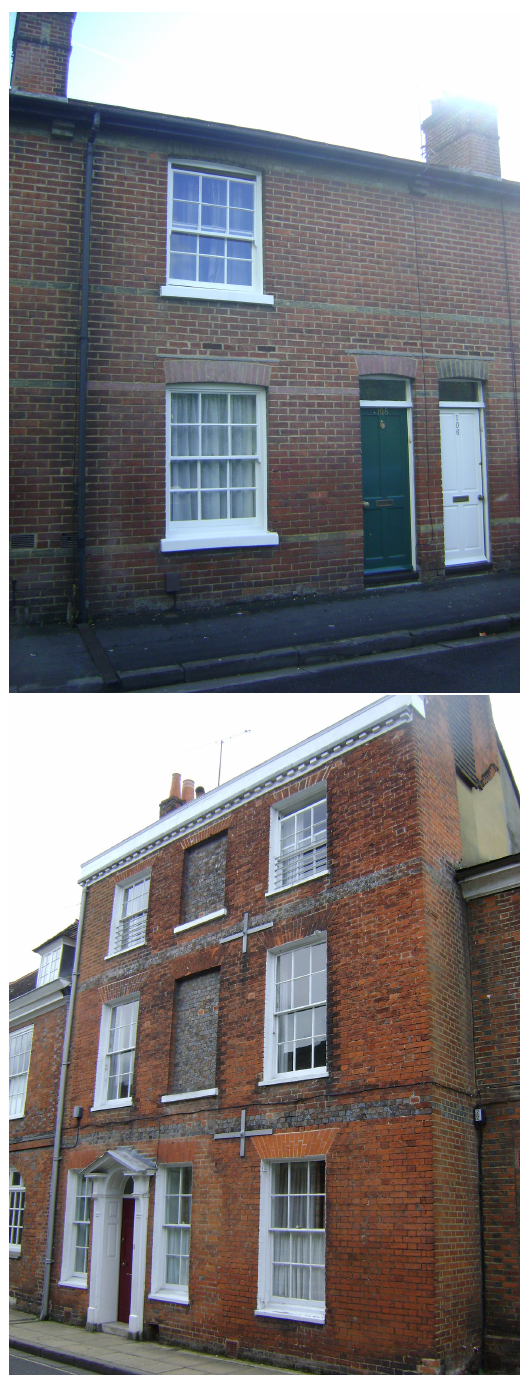
Fig. 7. (a) Water Lane, Winchester, (b) Kingsgate Street, Winch-